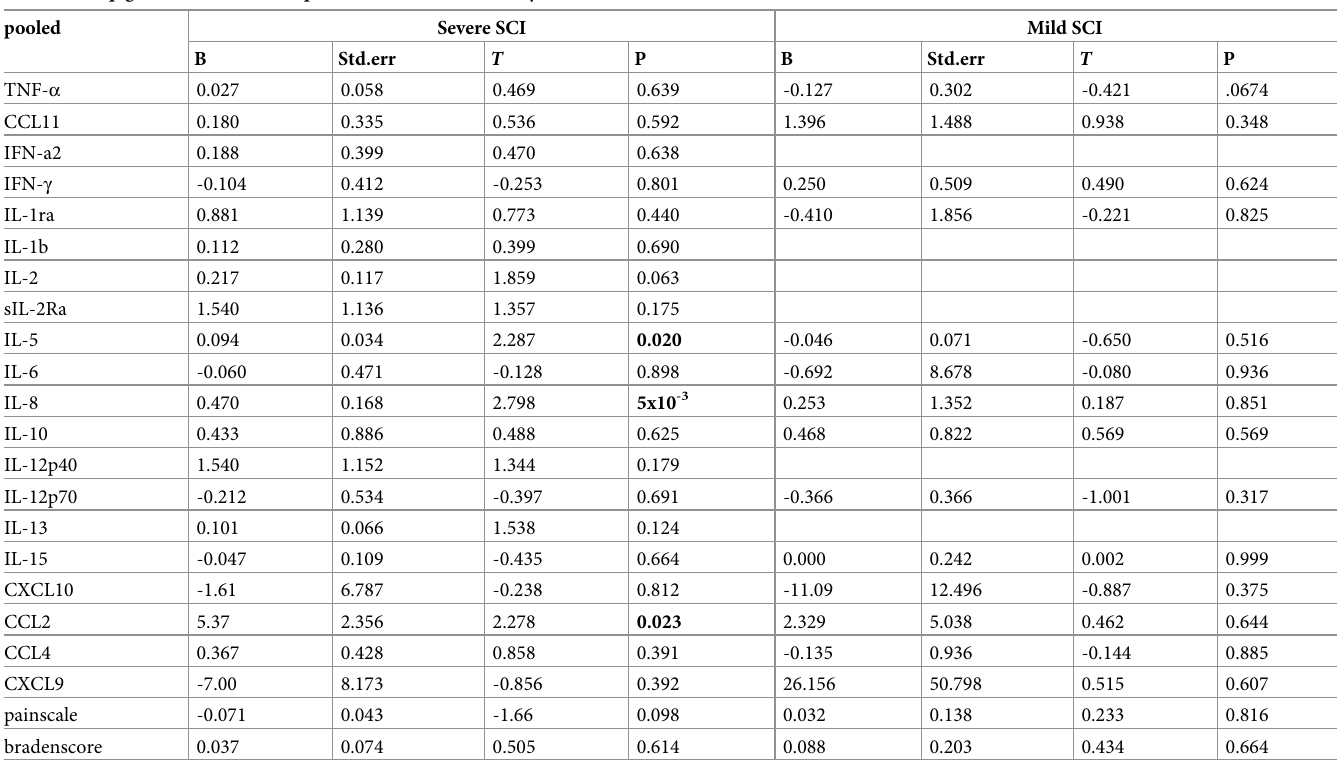
Table 4. Δ 2bp genetic effects on temporal effect of inflammatory mediators.